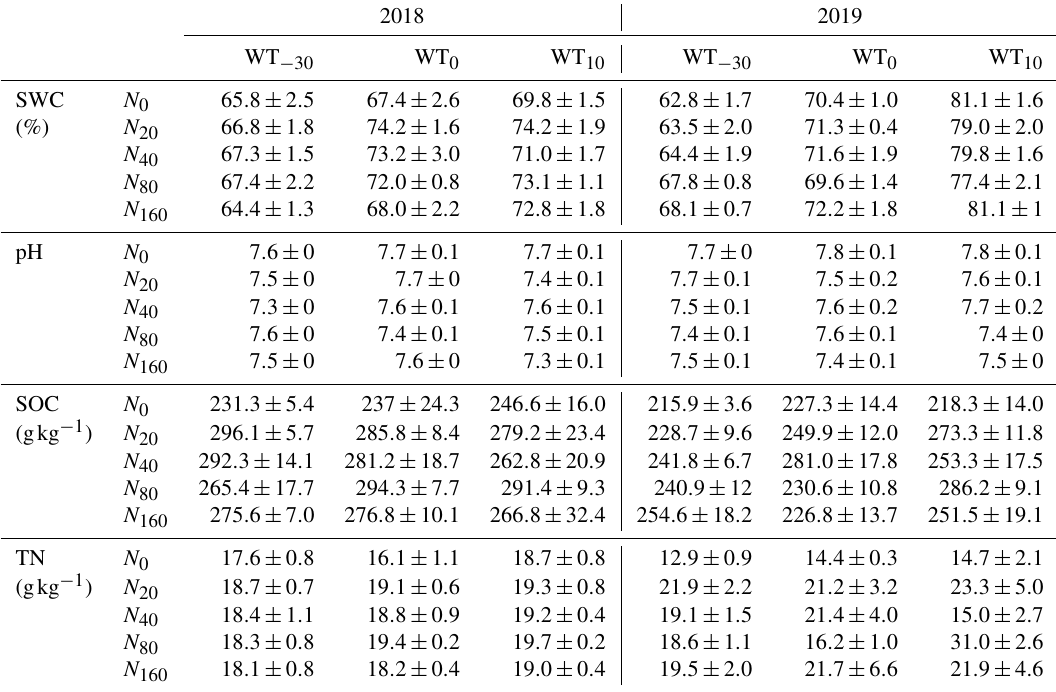
Table 1. Soil properties in the different water table (WT) treatments and nitrogen deposition (N) levels in 2018 and 2019.